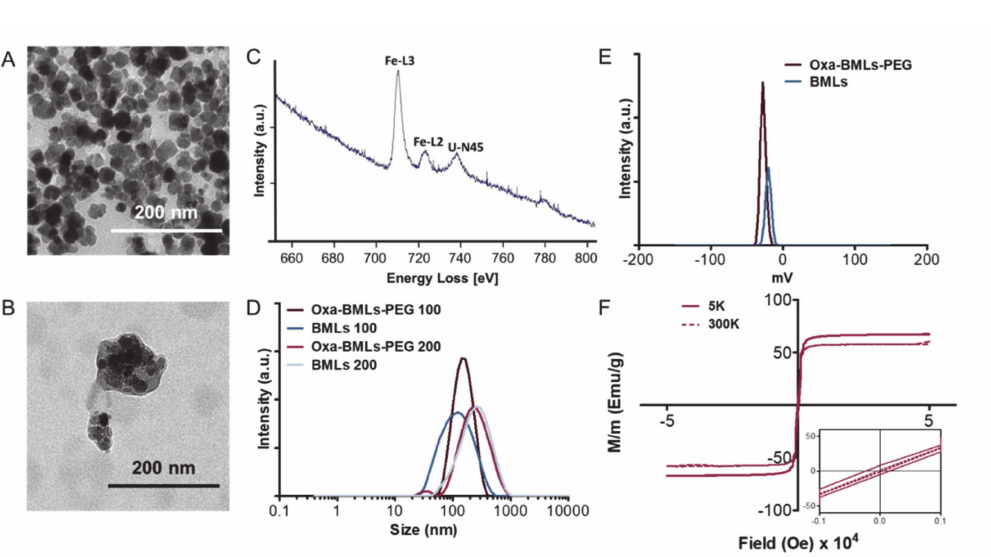
Figure 1. Characterizations of the di ff erent magnetoliposomes formulation. TEM images of ( A ) BMNPs and ( B ) Oxa-BMLs-PEG. ( C ) EELS spectrum of magnetoliposomes (U-N45 peak corresponds to uranile from negative staining). ( D ) Size distributions and ( E ) ζ potential of BMLs and Oxa-BMLs-PEG. ( F ) Hysteresis cycle of